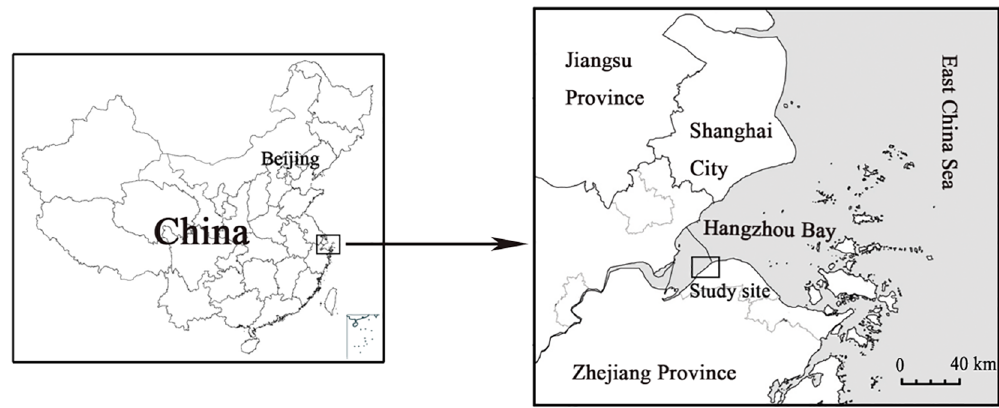
Fig 1. The geographical location of the study